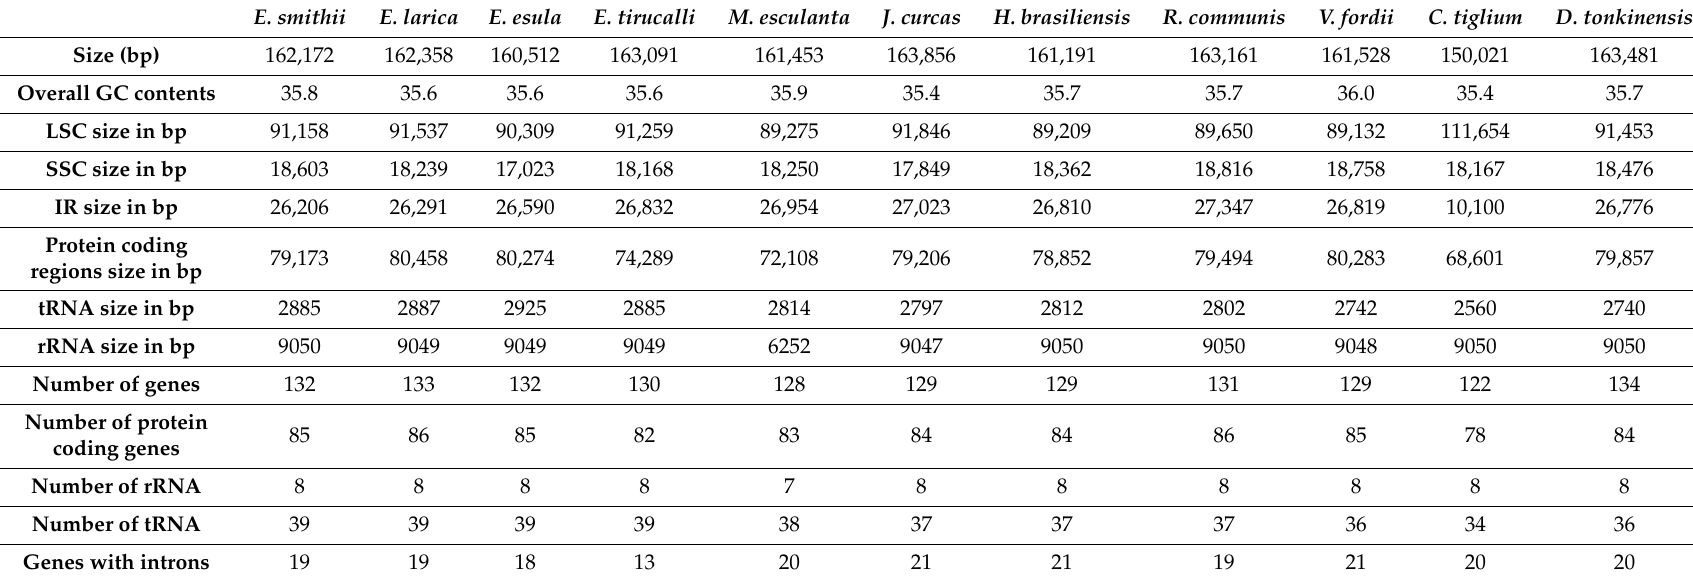
Table 1. Summary of complete chloroplast genomes of E. laica and E.